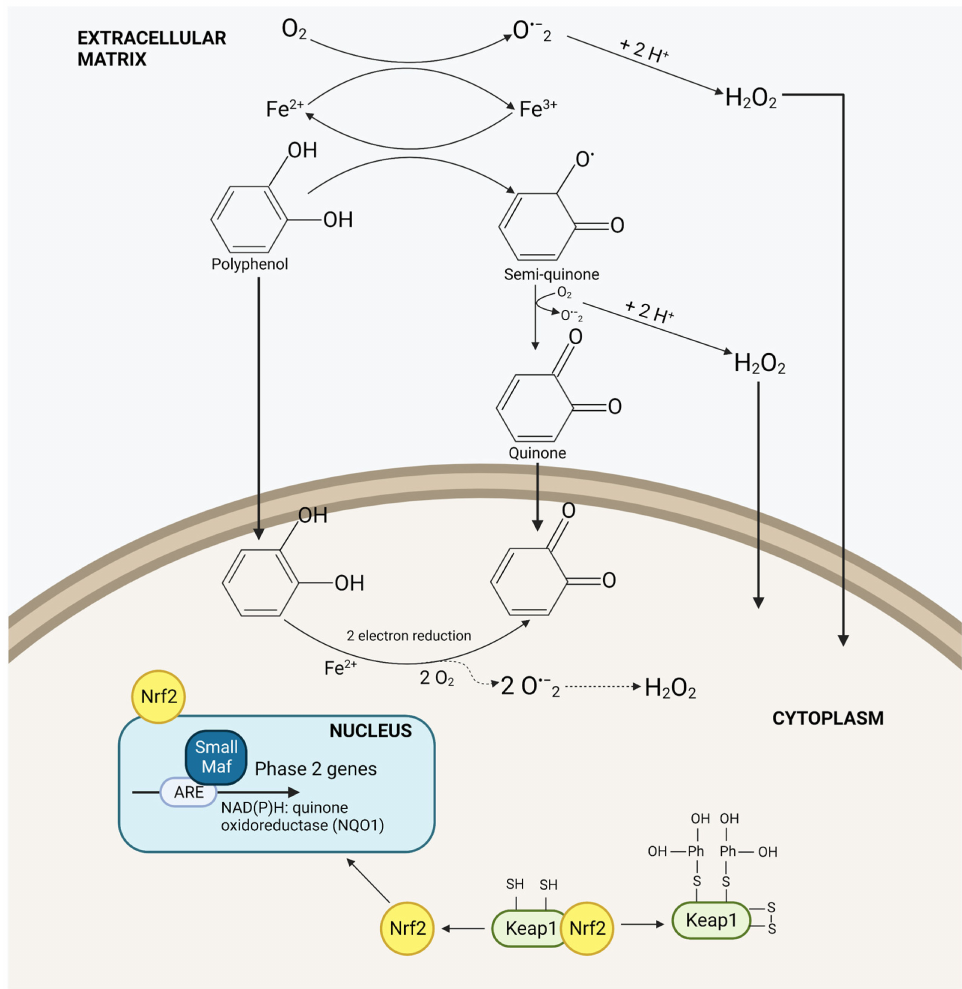
Figure 1. The activation of the Nrf2/Keap1 pathway by polyphenols.